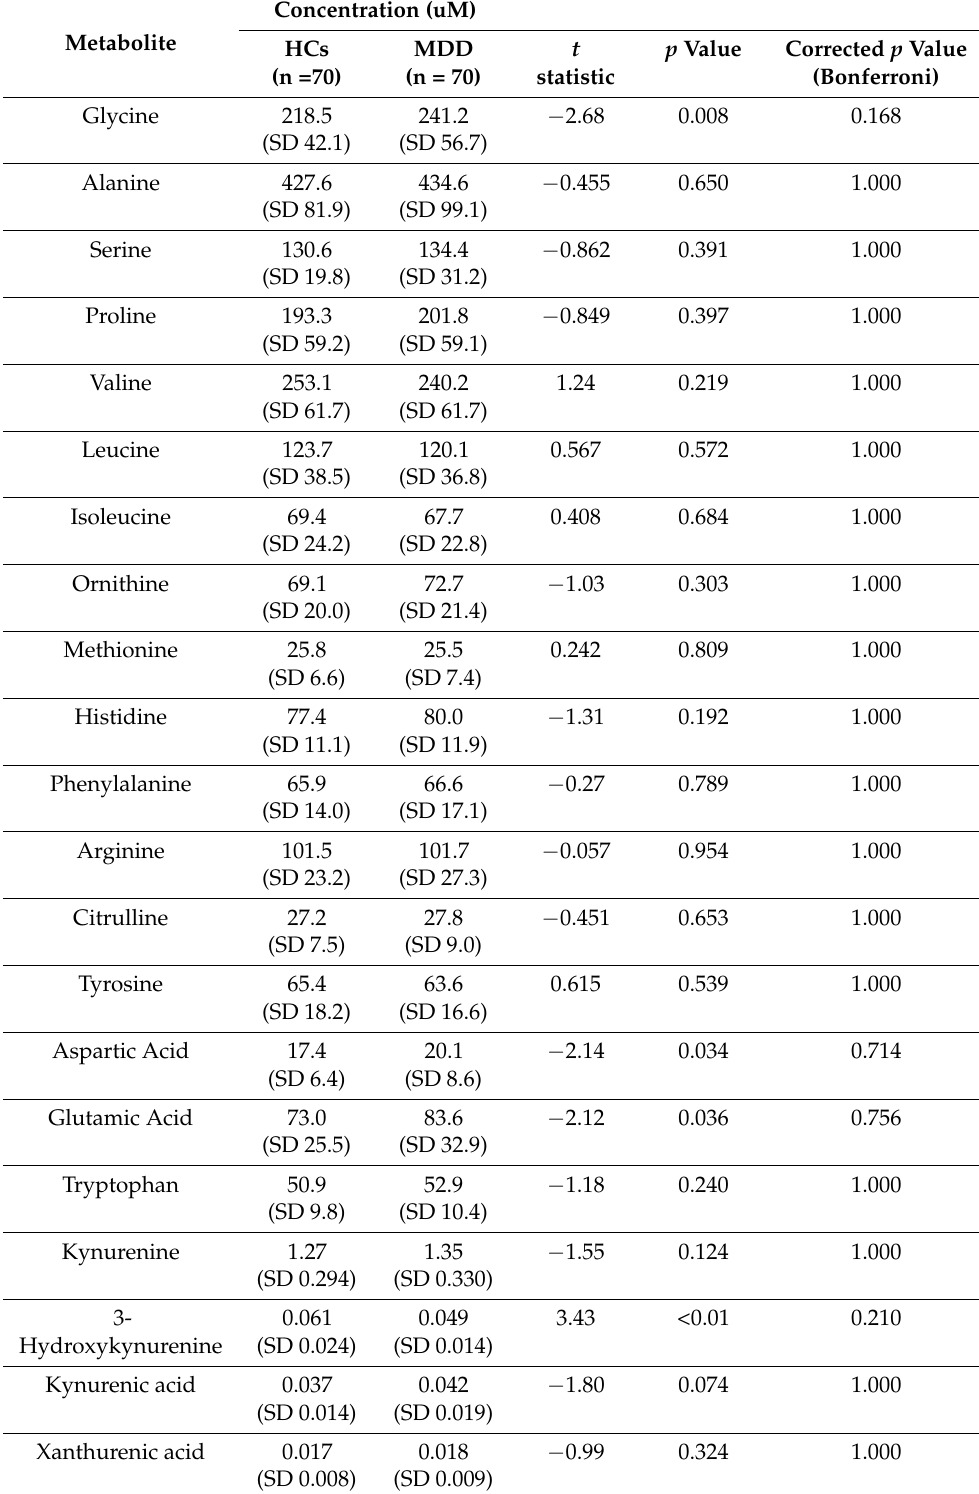
Table 2. Differences in mean metabolite concentrations of blood serum of HCs and MDD